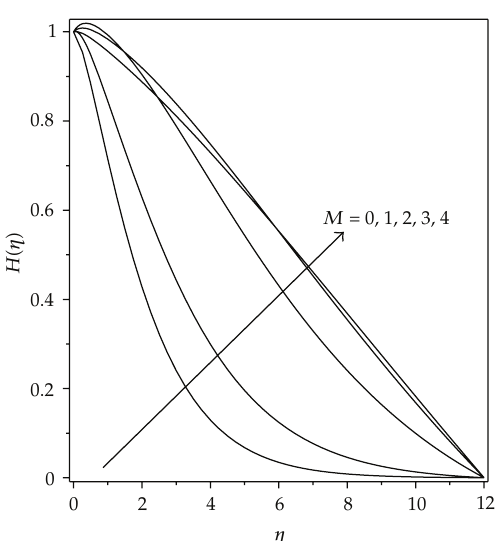
Figure 3: Concentration profiles for di ff erent values of M when Pr (cid:9) 0 . 78, Sc (cid:9) 0 . 6, D f (cid:9) 0 . 03, S r (cid:9) 2, (cid:9) 0. r (cid:9) 0, and f 0